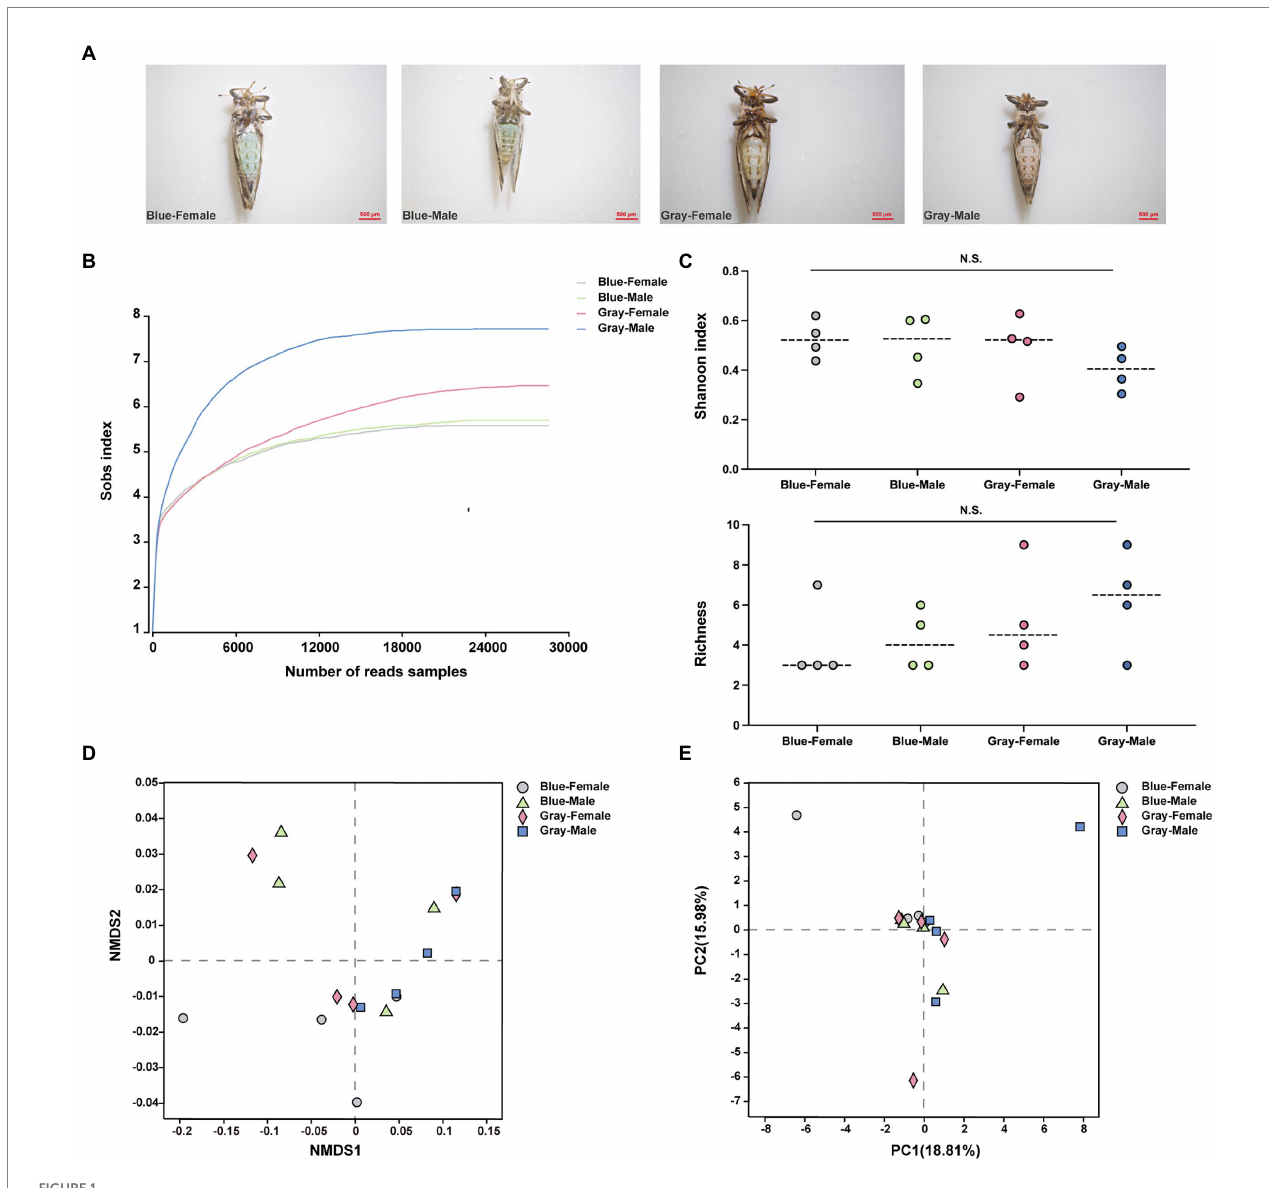
FIGURE 1 The alpha and beta analysis of different color morphs and genders of ACP adults. (A) Different color morphs and genders of ACP adults. (B) Rarefaction curves of read numbers in the different color morphs and genders of ACP. (C) Shannon index (up) and Chaol index (bottom) showed the bacterial community diversity and richness from different color morphs and genders of ACP adults. (D) Non-metric multidimensional scaling (NMDS) analysis. (E) Principal components analysis (PCA). The data sets were analyzed by the analysis of variance (ANOVA) followed by Tukey’s test, comparison of Shannon diversity and Chaol indices were by non-parametric analysis ( p > 0.05 means no significant difference. N.S., no